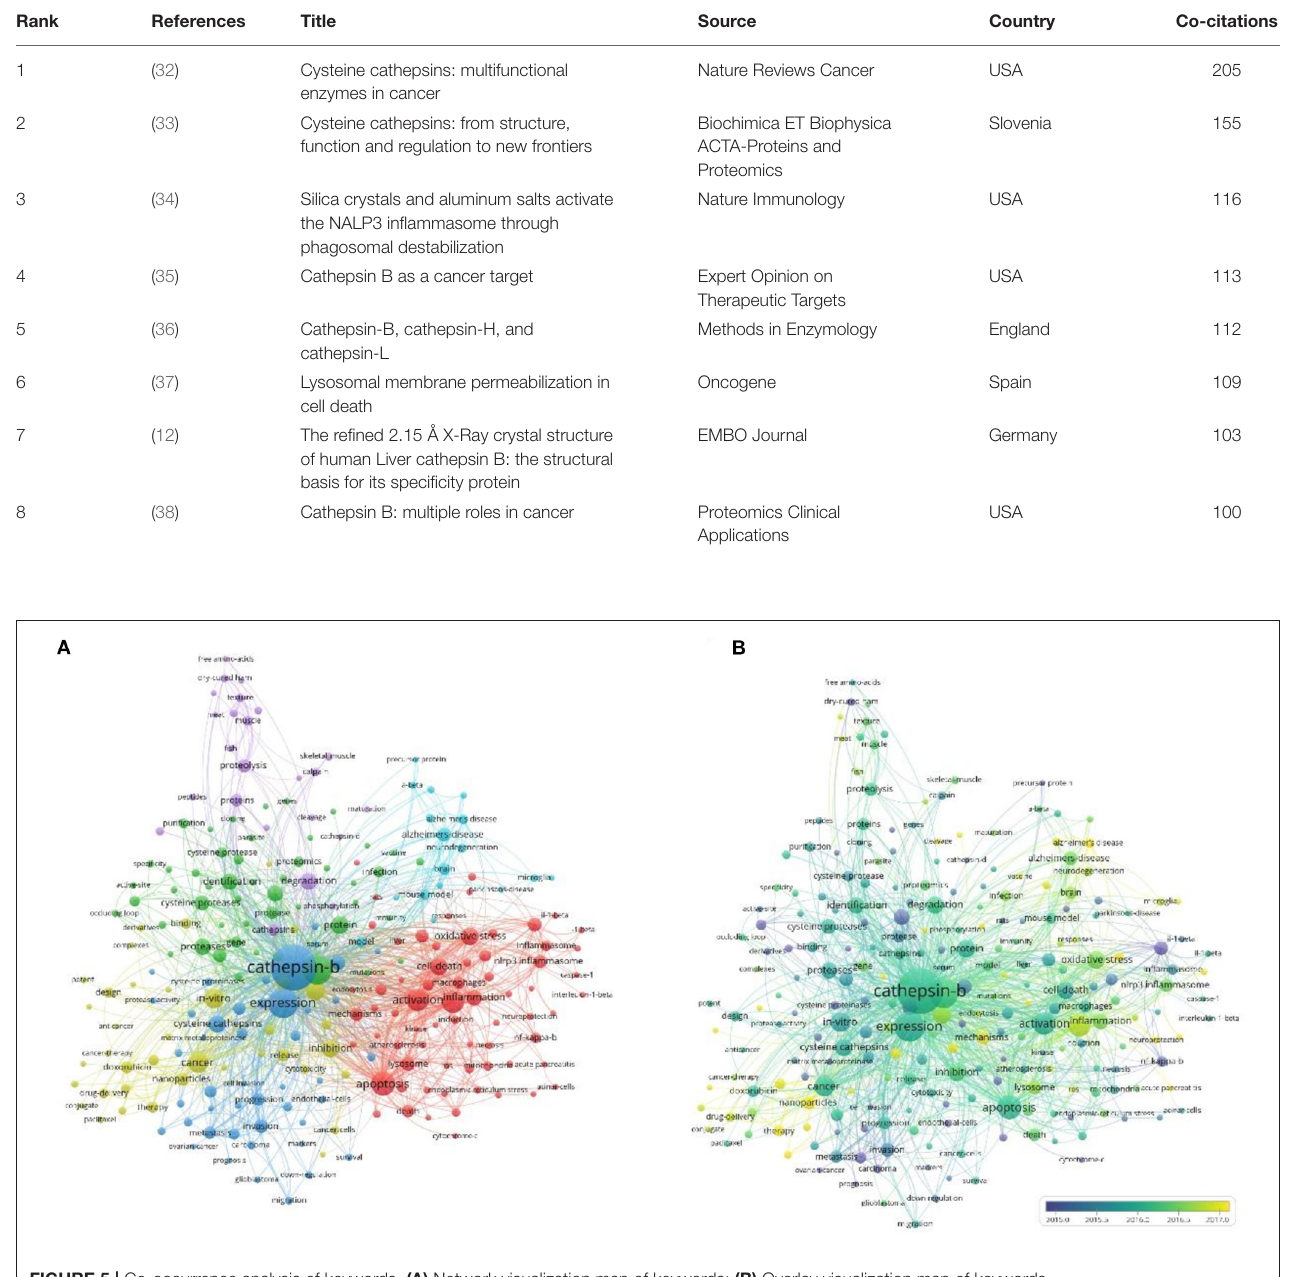
scientific journals and their collaborations showed the most prevalent journals and their connections with each other in the CTSB field. This may provide a valuable reference for beginners in this field and make it easier to find the related documents and submit novel discoveries in this